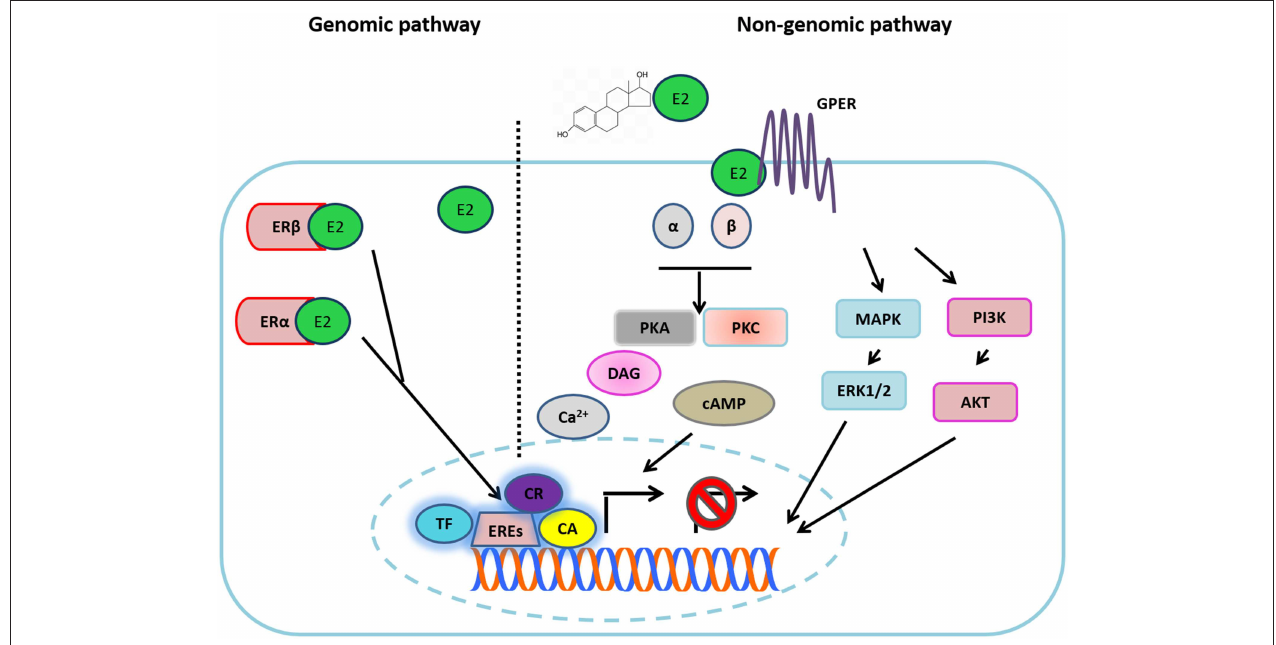
FIGURE 2 | Estradiol signaling. Estradiol (E2) can bind to its different receptors to activate the genomic pathway or the non-genomic pathways. In the first one, E2 binding to ER α and ER β , each complex is directed to the nucleus where it joins with EREs in the DNA, recruiting different transcription factors (TF), co-activators (CA), or co-repressors (CR) in order to activate or suppress the transcription of target genes. In the non-genomic pathway, E2 binds to GPR30, triggering the activation of G proteins. The above turns out in the increase of different second messengers (cAMP, Ca 2 + , DAG). Additionally, E2 can activate different growth factor receptor (GFR) activity through the non-genomic pathway, which results in the activation of different downstream signaling pathways (MAPK and PI3K) and in the release of different ligands of